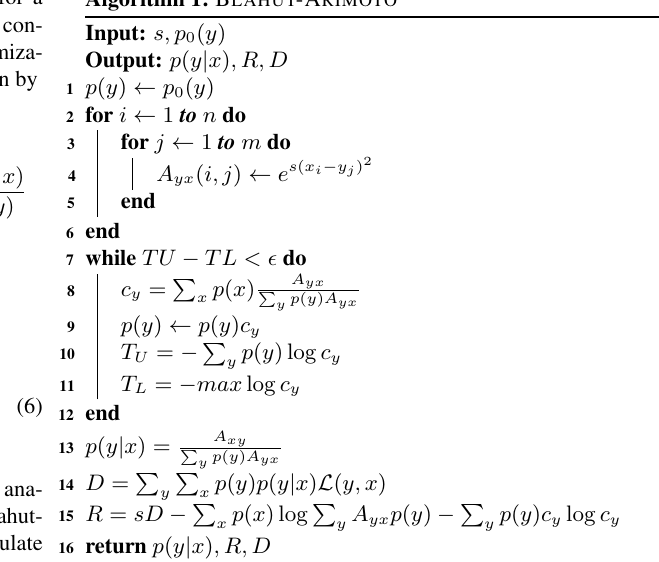
Algorithm 1: B LAHUT -A